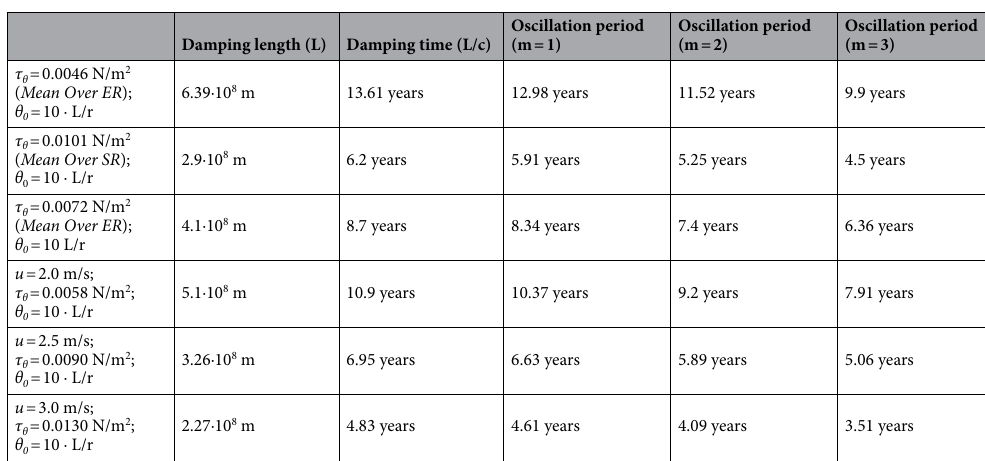
Table 1. Variation of damping length, damping time and oscillation period of the first three sea surface oscillation modes obtained with different values of τ θ . Wind stresses values in line 1 and 2 are obtained averaging the tangential wind stress in the period 1 Jan, 1993–31 Dec, 2016, over the “Eddy Region” (ER) and over the “Study Region” (SR) (Fig. S4), respectively. The value of τ θ in line 3 is obtained by averaging the tangential wind stress over the “Eddy Region” (ER) in the period 1 Jan, 2017–31 Dec, 2018. Lines 4–6 are meant to provide the reader with the order of magnitude of the variations of oscillatory parameters of the NIG in relation to wind